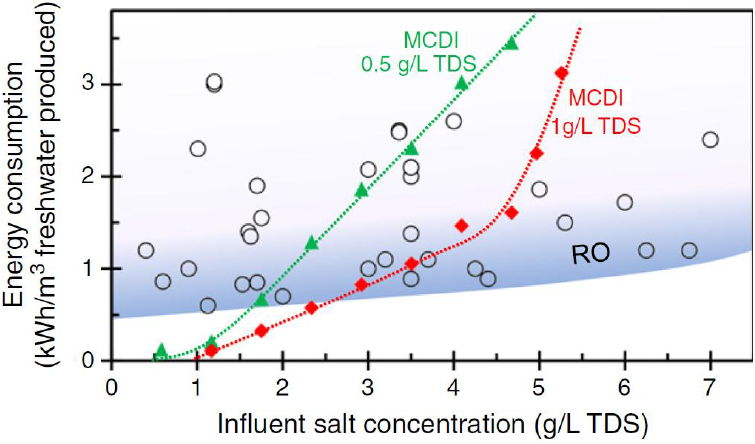
Figure 2. Comparison of energy consumption between MCDI and reverse osmosis. Triangles: energy consumption of MCDI to bring salt concentration to the level of 0.5 g L − 1 Total Dissolved Solids (TDS). Diamonds: energy consumption of MCDI to reduce salt concentration to 1 g L − 1 TDS. Circles: energy consumption of Reverse Osmosis (RO) collected from literature studies. Reproduced with permission from [16], copyright Elsvier, 2013.